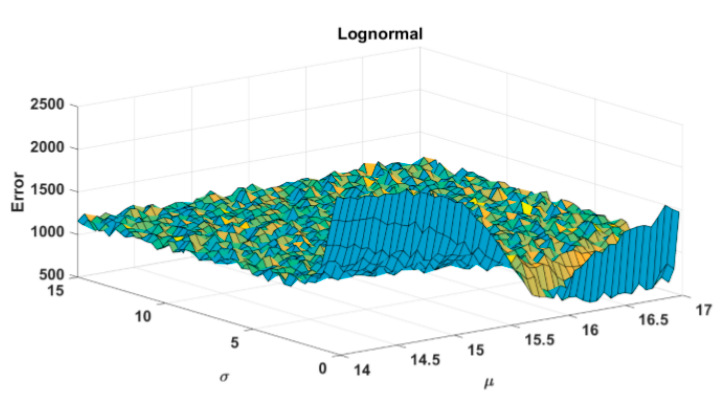
Figure 4. Validation error (Lognormal).